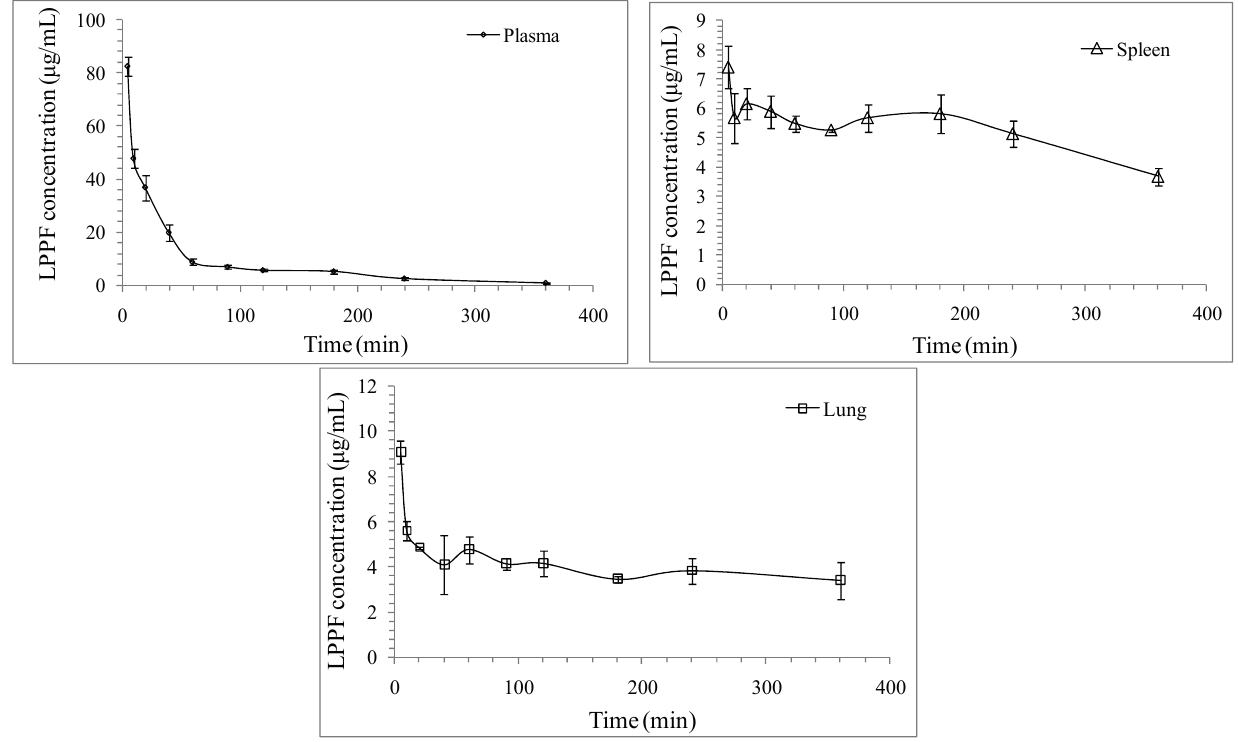
Figure 5 . LPPF concentration vs. time profile following intravenous (i.v.) administration at 40 mg/kg body weight. Data are represented as mean ± standard derivation ( n =